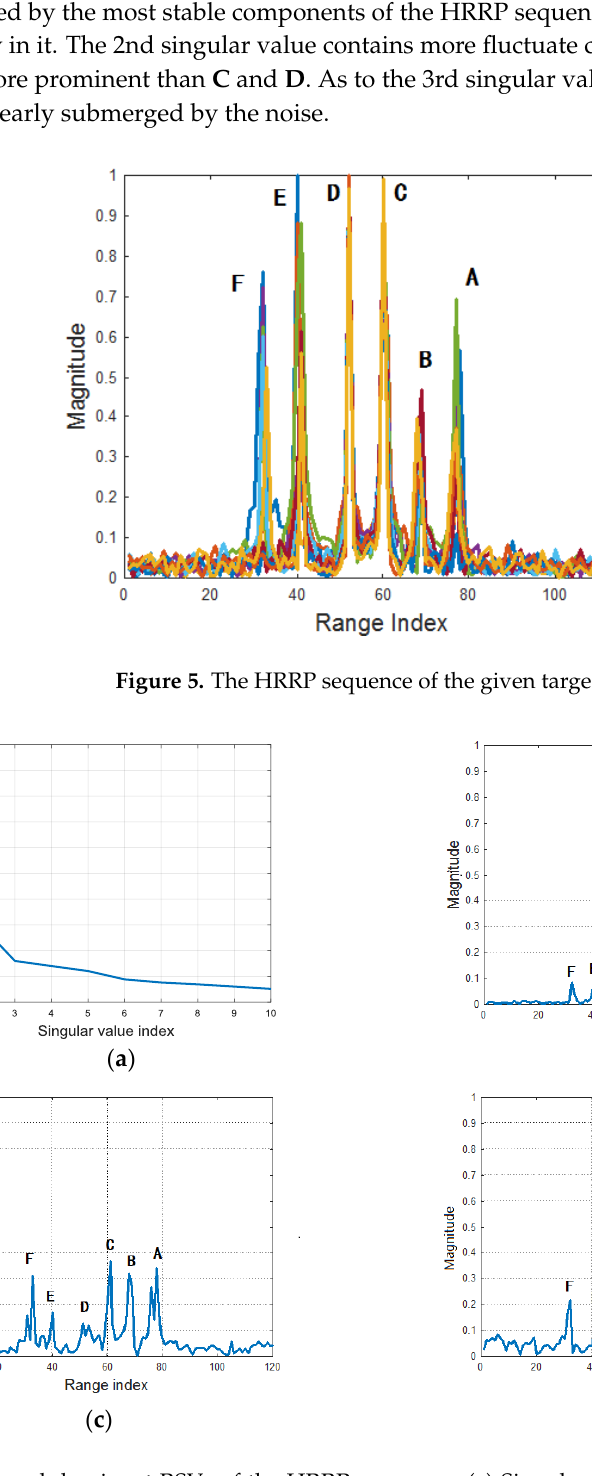
( c ) Figure 7. The scatterer extraction comparison for ANM, OMP and BP. ( a ) The scatterer extraction result via ANM; ( b ) The scatterer extraction result via OMP; ( c ) The scatterer extraction result via BP. The simulations above verify that, after SVD, the noise is reduced in the dominant RSVs, which increases the accuracy of scatterer extraction. Moreover, the most stable components of HRRPs are focused on the RSVs corresponding to the largest SVs. Moreover, ANM shows superiority in dominant scatterer extraction than OMP and BP, which is free of the off-grid problem.